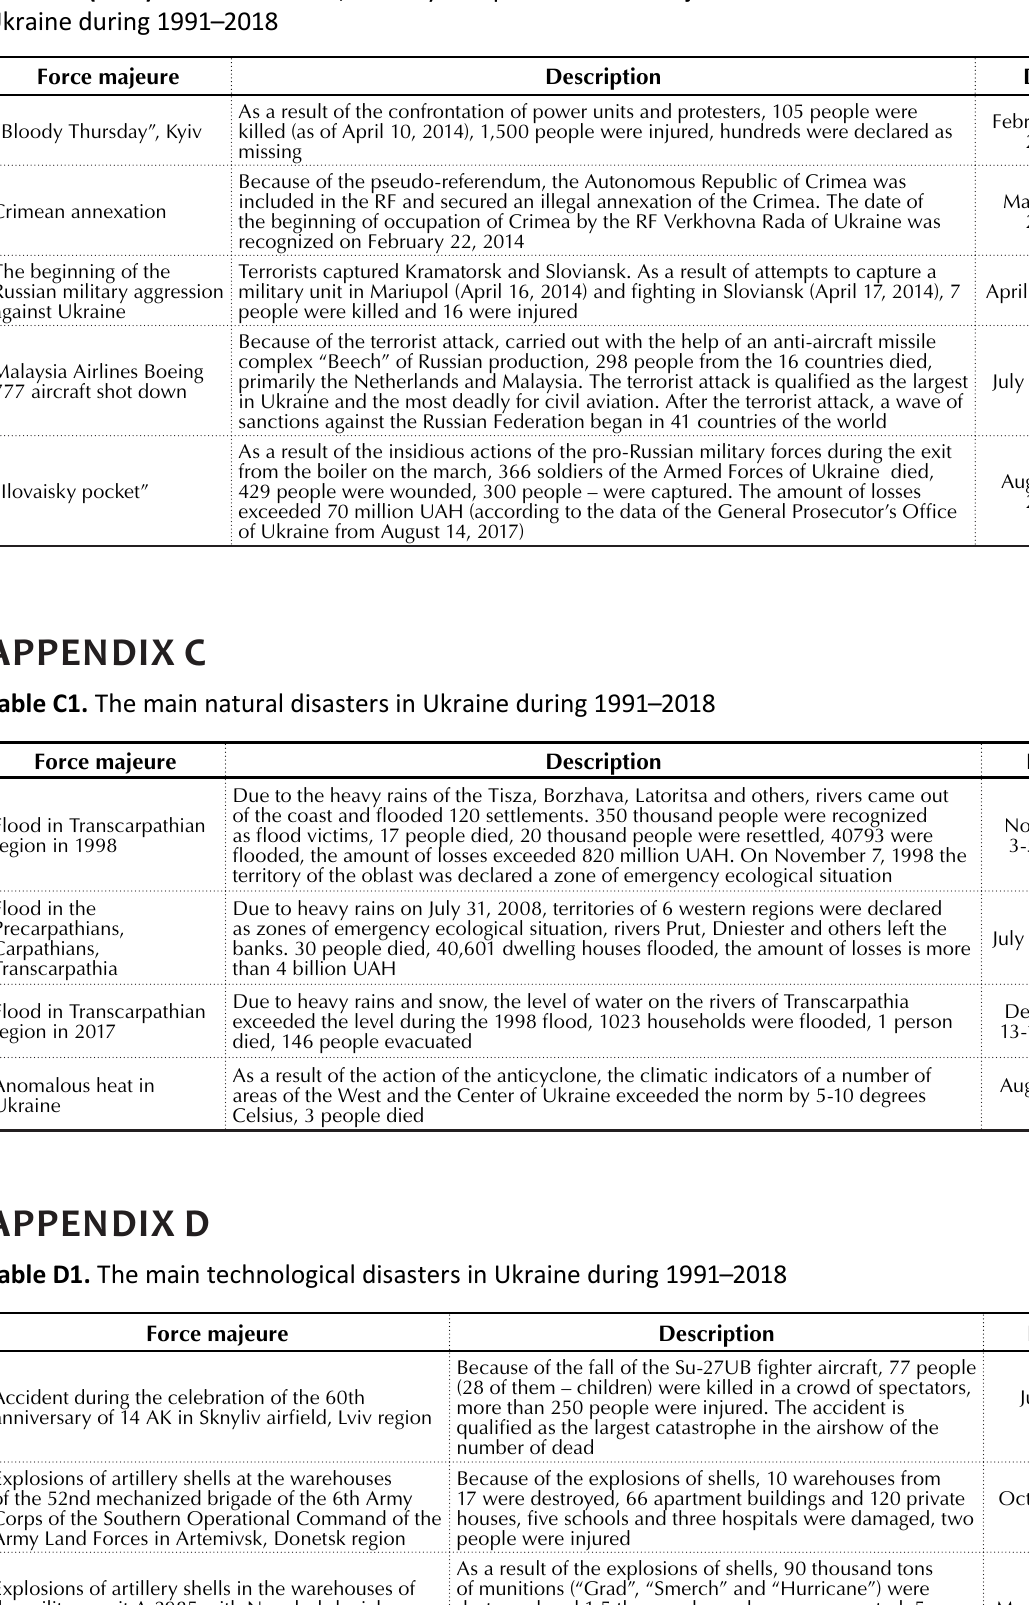
Table B1 (cont). The main social, military and political force majeure events and terrorist acts